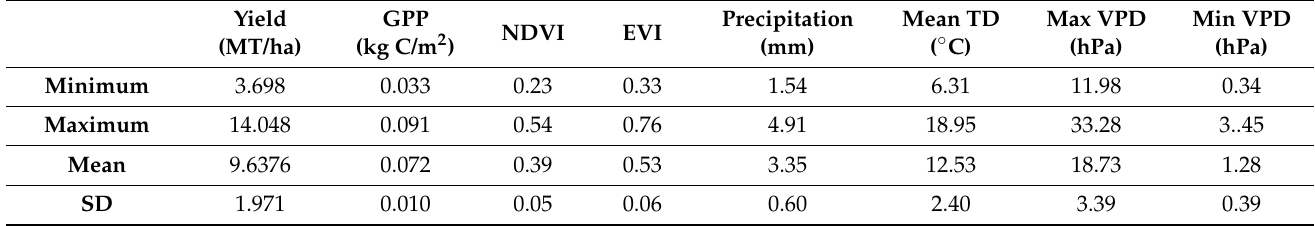
Table 2. The descriptive statistics of the seven features related to corn